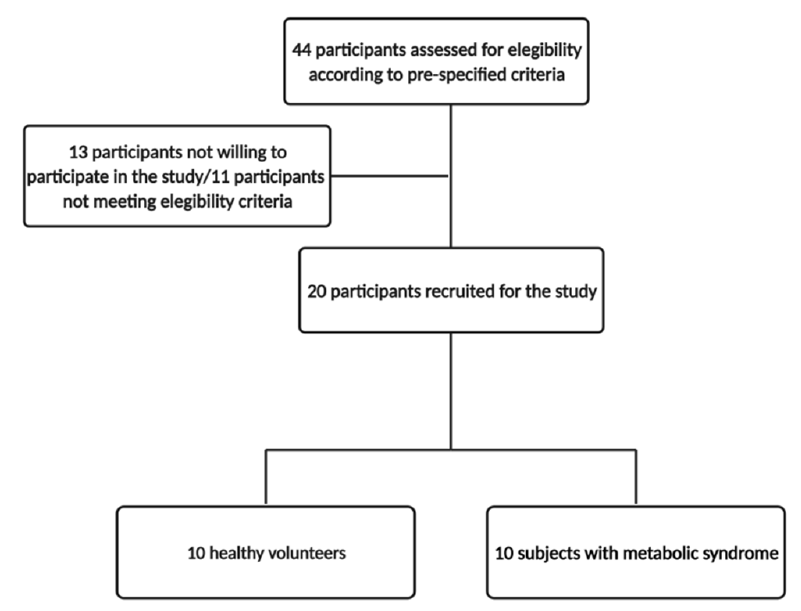
Figure 1. Study course flowchart.